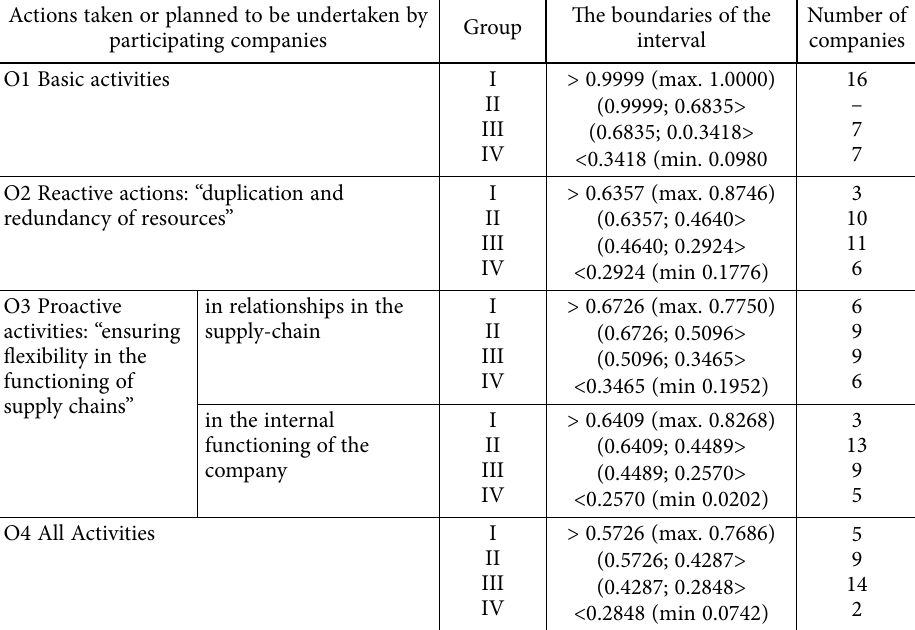
Table 4. Division of surveyed enterprises into typological groups Actions taken or planned to be undertaken by participating companies O1 Basic activities I